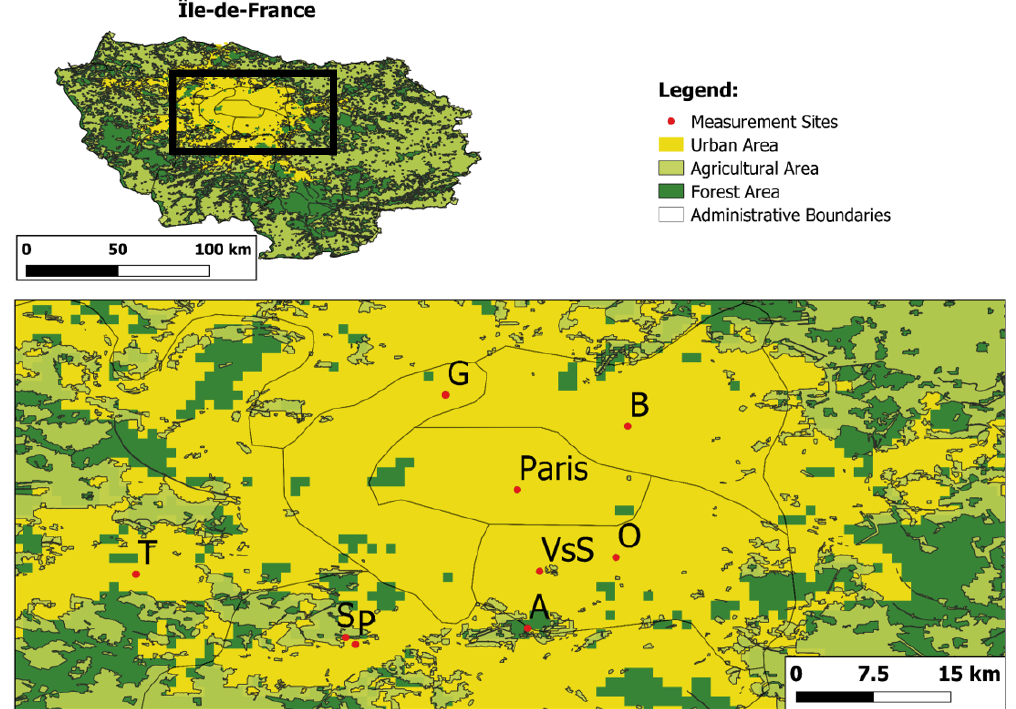
Figure 1. Outline of the Paris region and a zoomed-in view of the relevant sites (A – Airport Orly, B – Bobigny, G – Gennevilliers, O – OASIS, P – Palaiseau, S – SIRTA, T – Trappes, VsS – Vitry-sur-Seine) using shapefiles provided by data.gouv.fr (https://www.data.gouv.fr/fr/datasets/ espaces-agricoles-de-la-region-ile-de-france-inscrits-sur-la-cdgt-du-sdrif-arrete-en-2012-idf/#discussion-5cc30bdb8b4c4166219c058e, last access: 30 April 2019) and processed with QGIS